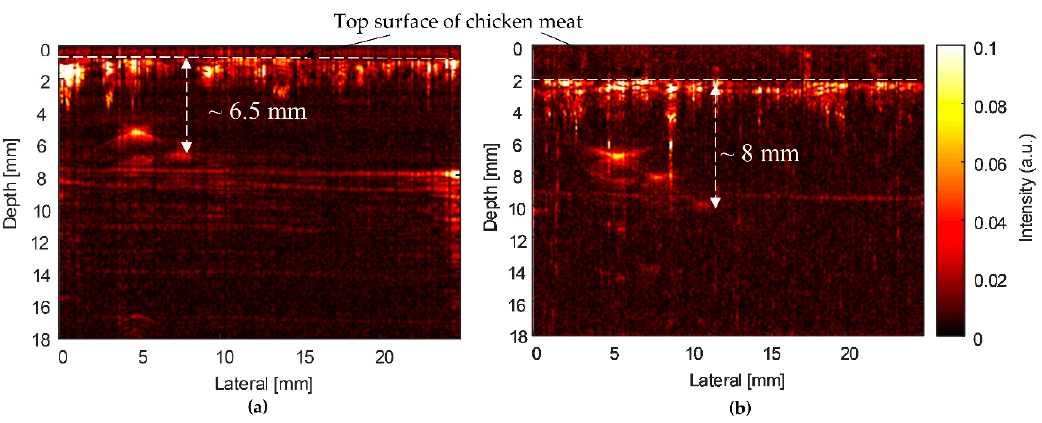
Figure 16. PAM images of the CHb phantom acquired using ( a ) SFP and ( b ) MFP transducers.